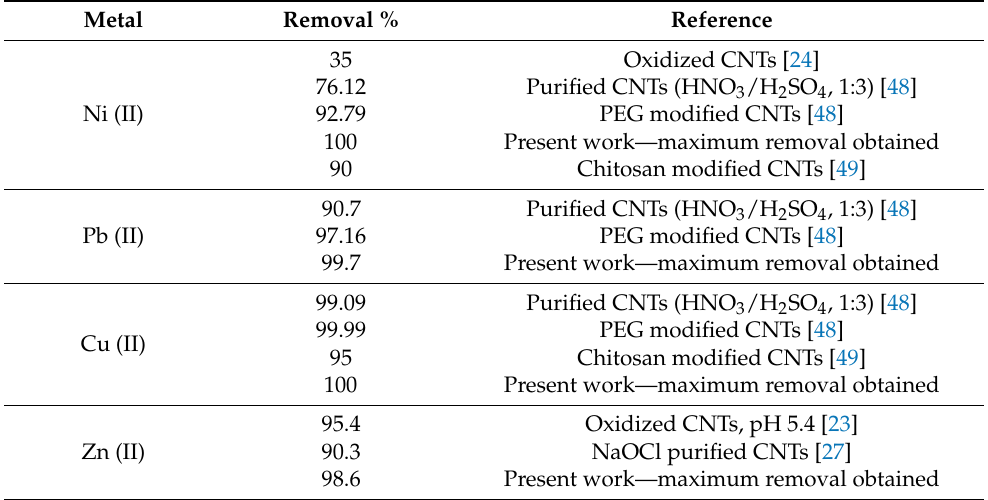
Table 7. Comparison of removal efficiencies obtained in the present study with information from the